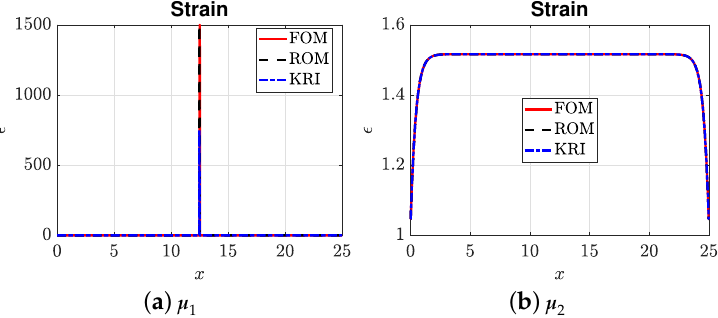
(corresponding to a completely broken bar) and µ 1